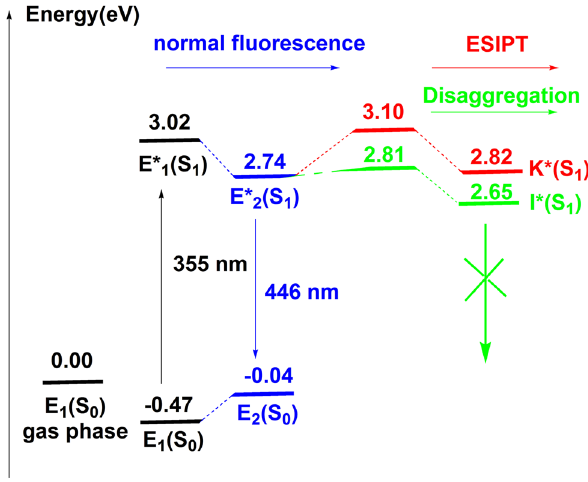
Figure 2: The fl uorescence in the water solvation.